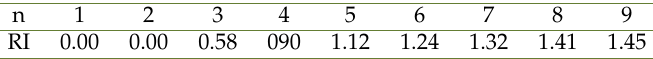
Table 2. AVERAGE RANDOM CONSISTENCY INDEX